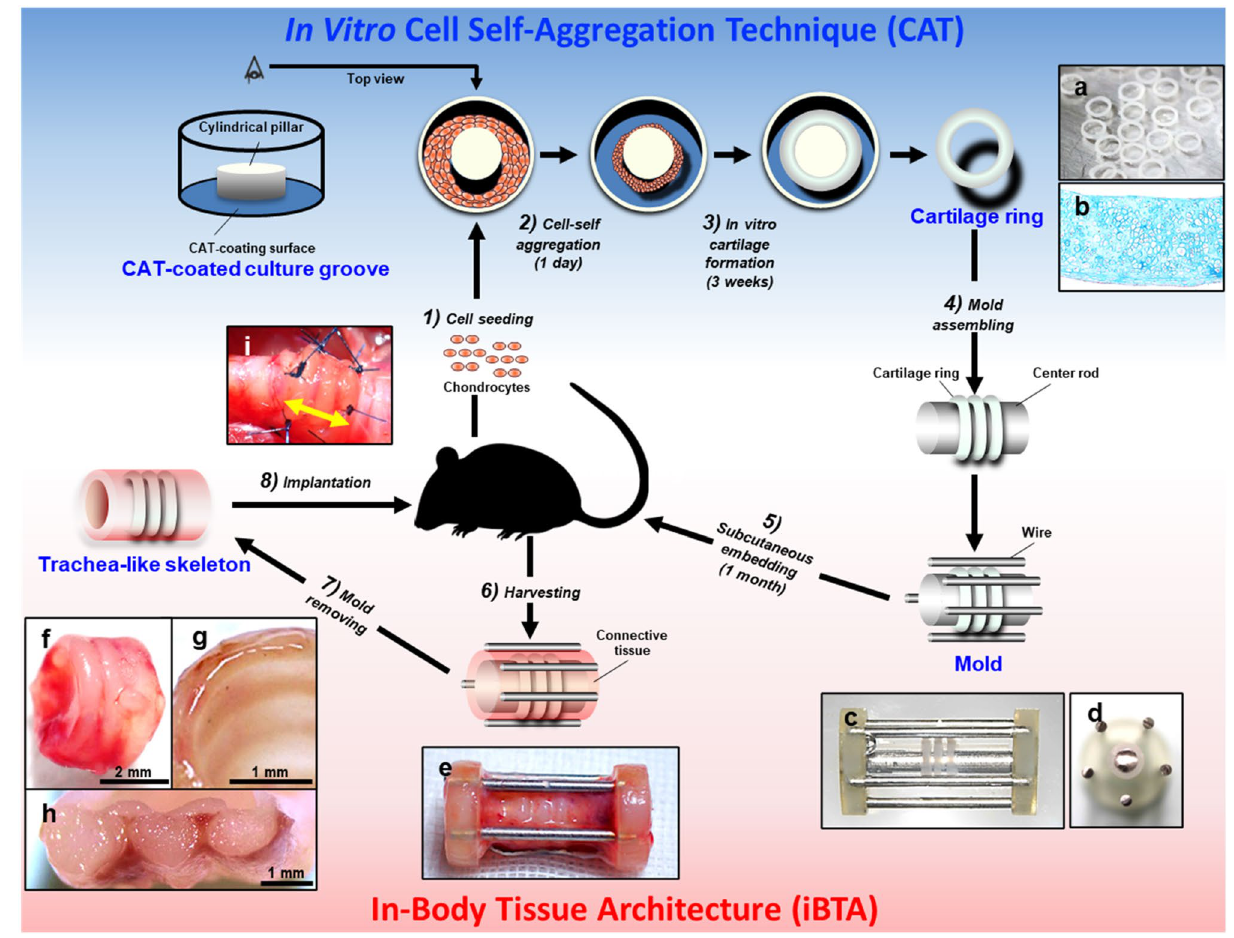
Figure 1. Biofabrication scheme of the tracheal analogue using in vitro cell self-aggregation and iBTA. The cartilage rings were prepared by seeding the chondrogenic lineage cells on an originally developed cell self- aggregation induction culture groove ( 1 – 3 ). The cartilage rings were assembled with a mold for body tissue architecture and implanted subcutaneously ( 4 , 5 ). After four weeks, the cartilage rings were connected to the connective tissues and capillary network, and a tracheal analogue was formed ( 6 , 7 ). The analogues were implanted into the trachea in an allogeneic manner ( 8 ). Alcian blue-stained matured cartilage rings were reproduced ( a , b ). Macroscopic images of the mold ( c , side view; d , cross view) assembled with the cartilage rings ( e ). Macroscopic images of the outer surface ( f ), lumen ( g ), and cross-section ( h ) of the tracheal